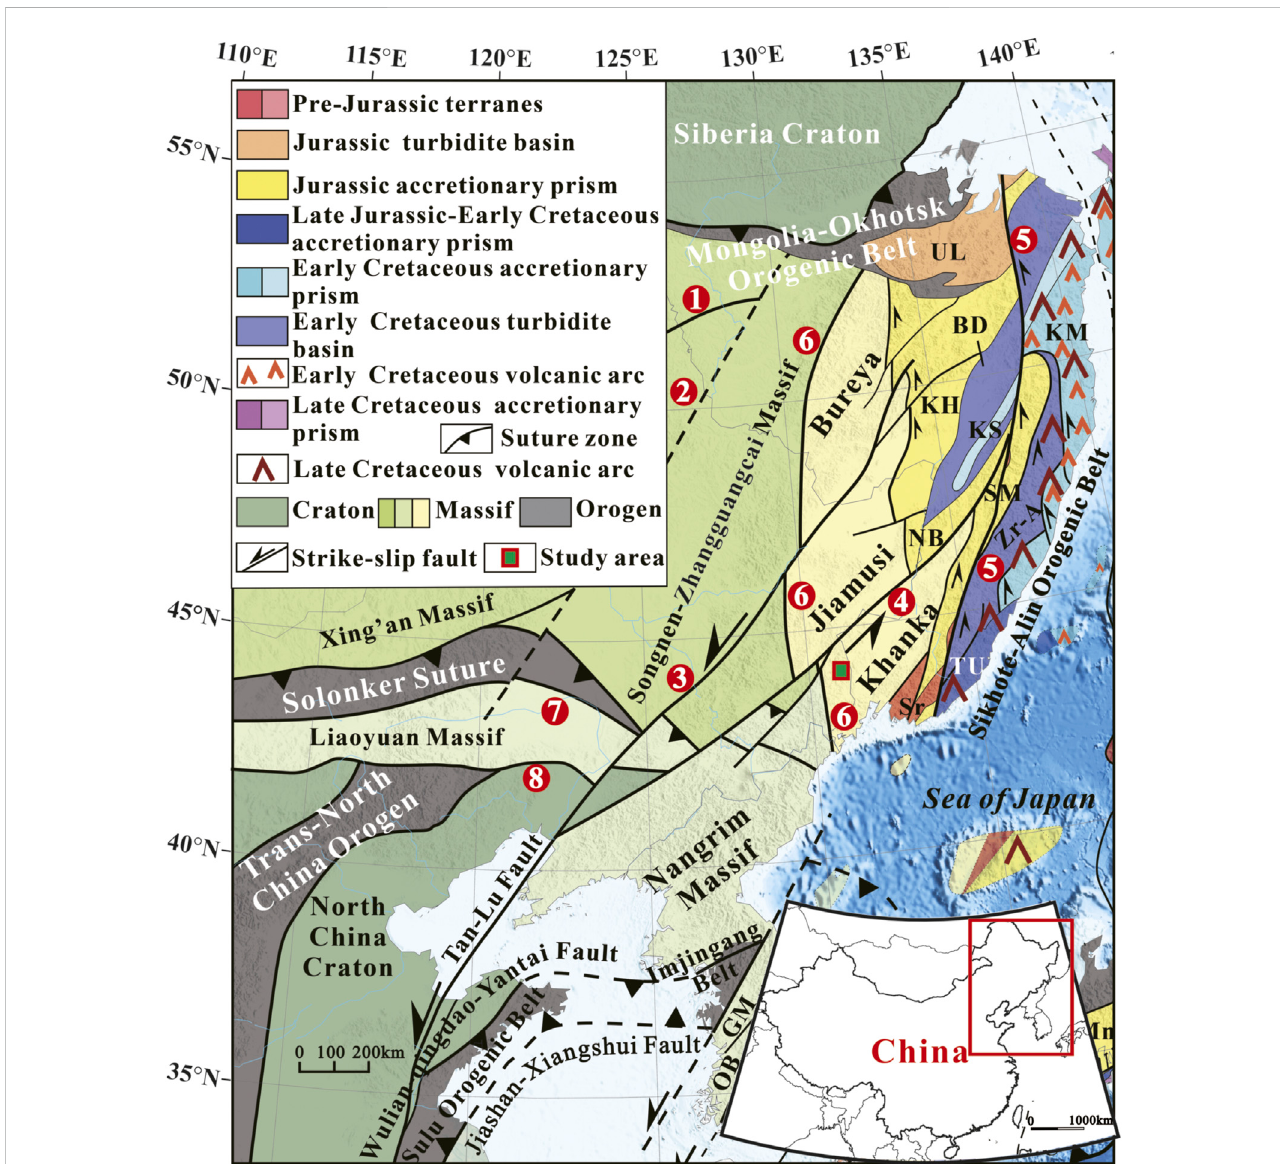
FIGURE 2 Simpli fi ed tectonic units of NE China (modi fi ed from Liu et al., 2021; Lan et al., 2022). 1-Xinlin-Xiguitu Fault; 2-Hegenshan-Heihe Fault; 3-Yilan-Yitong Fault; 4-Dunhua-Mishan Fault; 5-Central Sikhote-Alin Fault; 6-Jiayin-Mudanjiang Fault; 7-Solonker-Xar Moron-Changchun-Yanji Fault; 8-Northern margin fault zone of North China; BD-Badzhal; GM-Gyeonggi Massif; KH-Khabarovsk; KM-Kema; KS-Kiselevka-Manoma; NB-Nadanhada-Bikin; OB-Okcheon Belt; SM-Samarka; Sr- Sergeevka; TU-Taukhe; UL-Ul ’ ban;